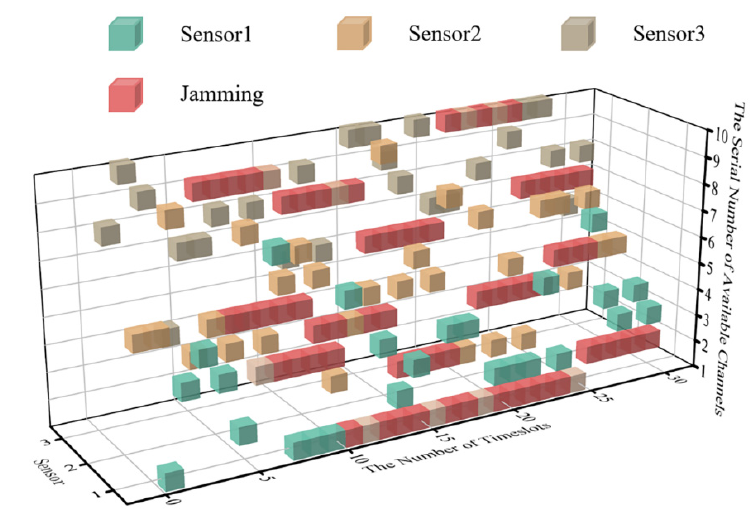
Figure 9. The cubic diagram of DAJA’s initial state. To keep the length of time of the system’s convergent state consistent with that of the initial state, timeslots from 2000 to 2030 are selected for comparison. The real-time diagram of transmission jamming is shown in Figure 10 when the system is